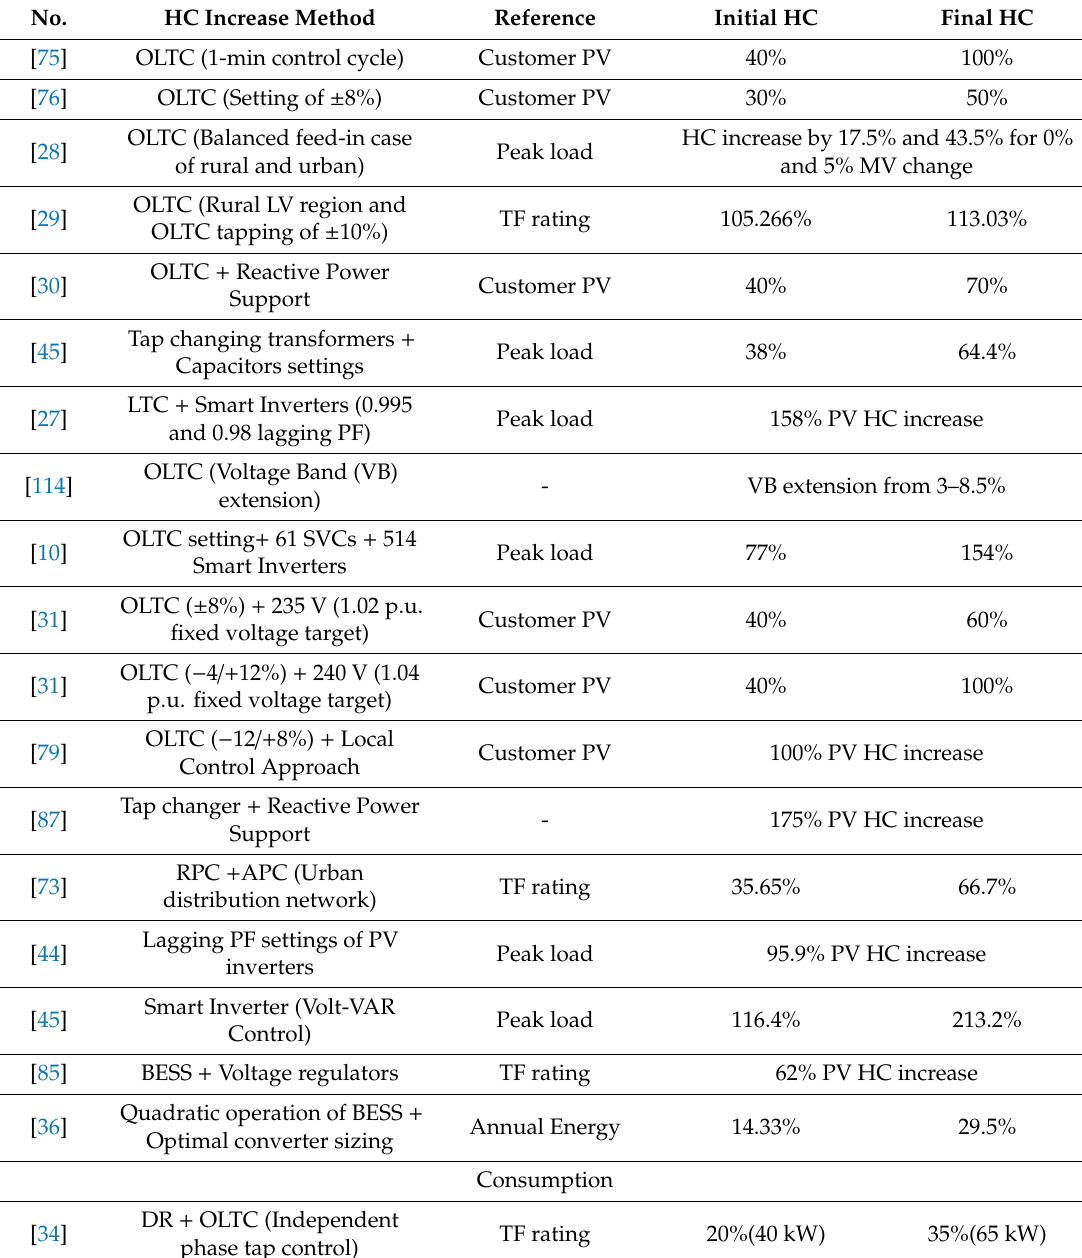
Table 7. Summary of HC improvement methods depicting the percentage increase in